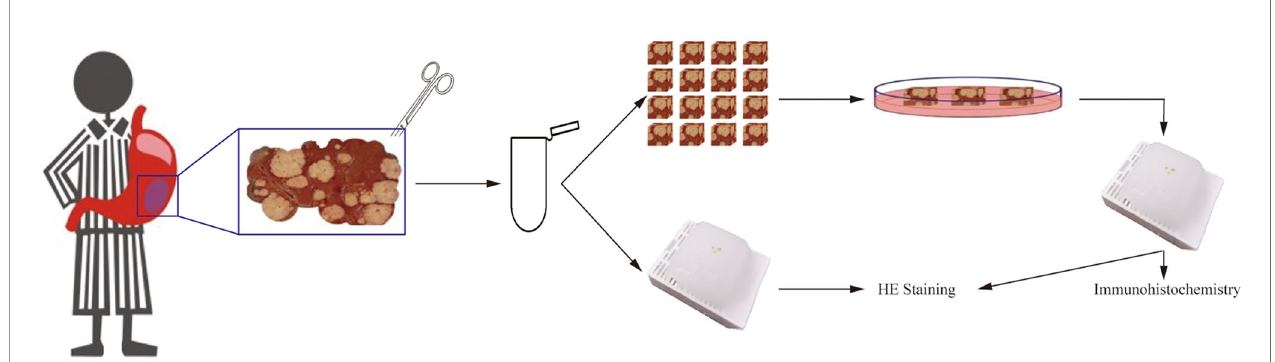
FIGURE 1 | Tumor tissue collection, preparation, and